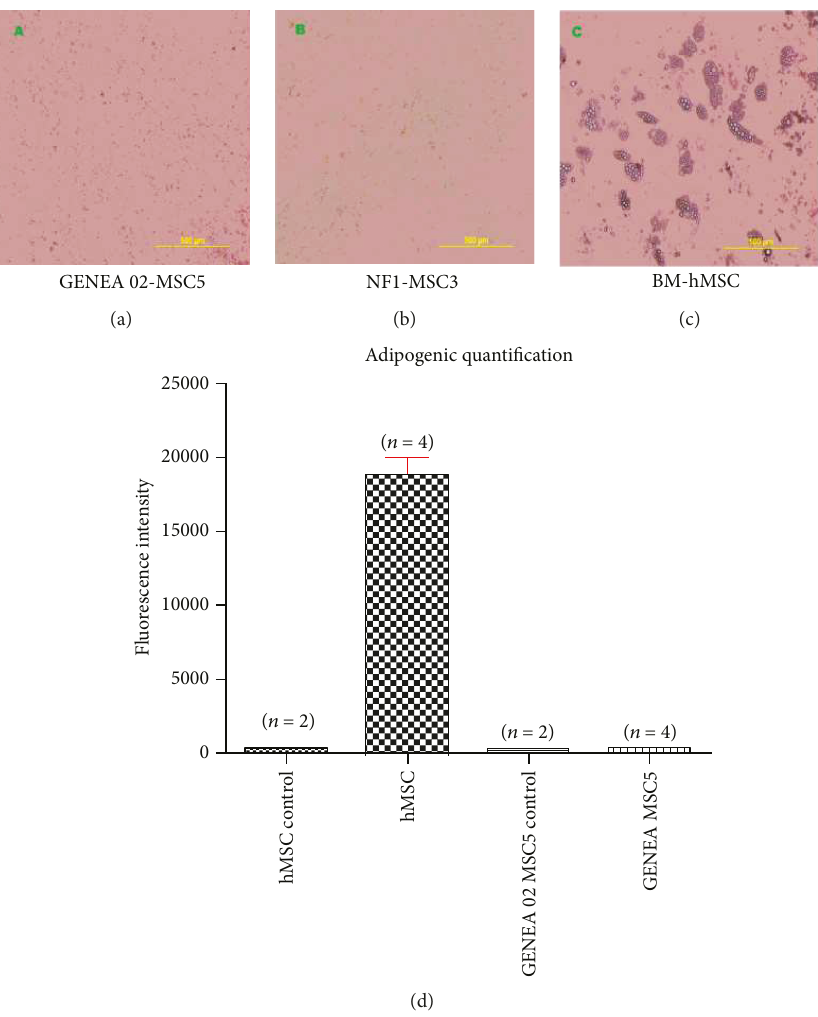
Figure 7: Morphological characteristics of GENEA 02-MSC5 (a), NF1-MSC3 (b), and BM-hMSCs (c) after 28 days of directed adipogenic di ff erentiation. No signs of adipogenic di ff erentiation were observed in GENEA 02-MSC5 and NF1-MSC3 cells after 28 days of directed adipogenic di ff erentiation. The presence of lipid-rich vacuoles within cells was only observed in BM-derived MSCs. (d) Average fatty acid concentration in BM-hMSCs and ESC-derived MSCs after 28 days of culture in adipogenic di ff erentiation/maintenance media or MPC Growth MEM media. A higher fatty acid synthesis was only observed in BM-derived MSCs after 28 days of directed adipogenic di ff erentiation when compared with the concentration of calcium detected in GENEA 02-MSC5 cells subjected to standard adipogenic di ff erentiation and GENEA 02-MSC5 and BM-hMSCs (negative controls) cultured in MPC Growth MEM media during the same period of